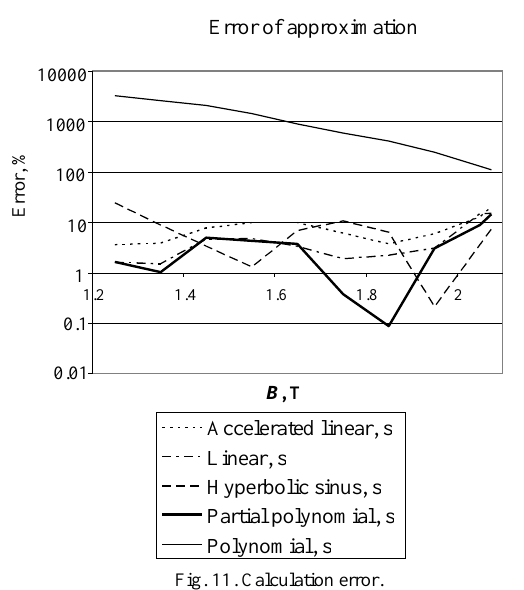
Fig. 11. Calculation